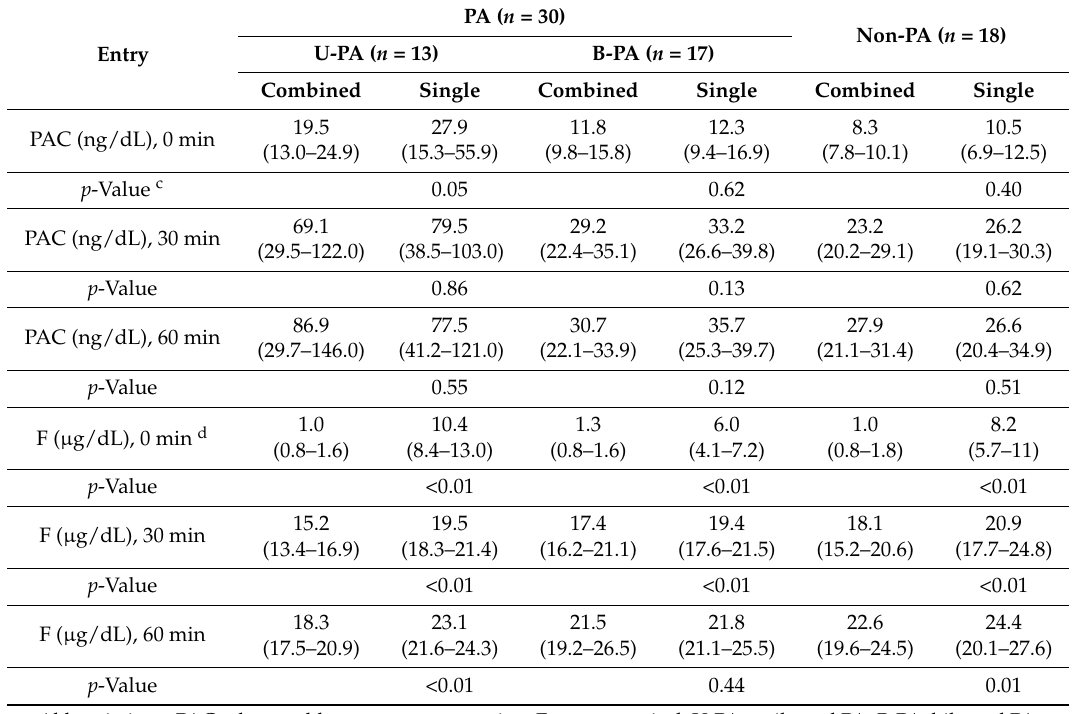
Table 2. Comparison of PAC and F responsiveness to ACTH stimulation between combined and single tests a,b .